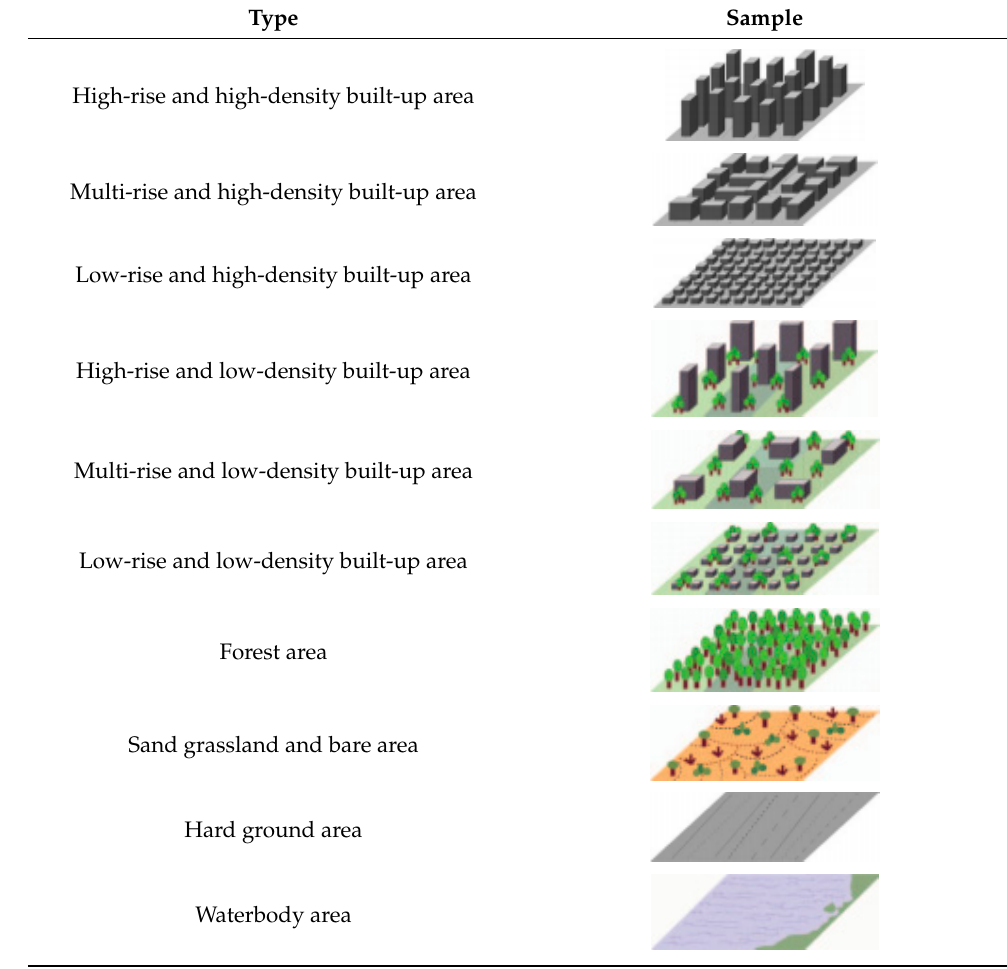
Table 1. LCZ types of the study area.